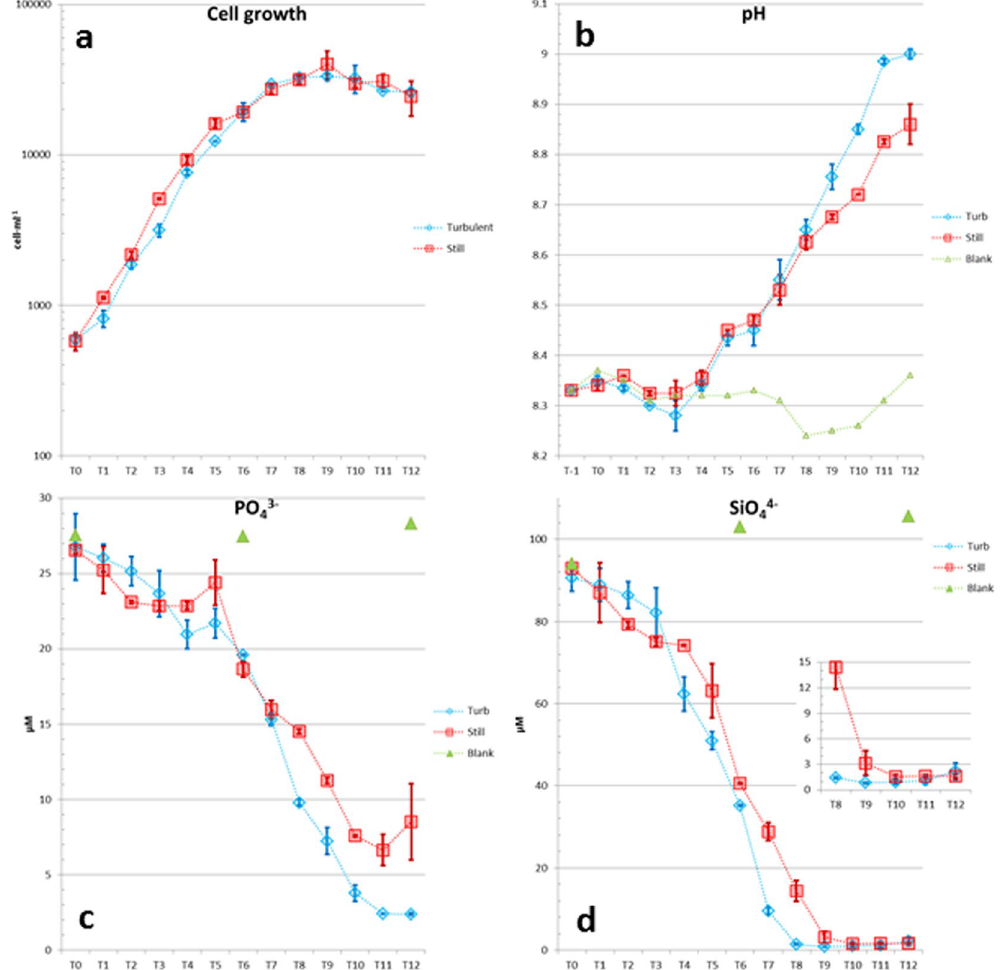
Figure 2. Growth curves ( a ), pH values ( b ) and nutrient concentrations ( c, d ) over the experimental days (T0- T12). ( a ). Cell concentrations over the experimental days. Logarithmic y axis. ( b ). Mean pH measurements. Still cylinders were always gently stirred before sampling (see methods). ( c ). Phosphate and ( d ). silicate measurements in Turbulent and Still conditions. Inset: zoom-in of the portion between T8 and T12. In the turbulent condition the threshold silicate concentration (ca. 1–2 µ M 33, 34 ) for diatoms was reached. Abscissa always represents experimental days. Values are means of the duplicates (n = 2) and vertical bars indicate maximum and minimum values. Blue diamonds indicate turbulent condition, red squares the still condition and, where applicable, triangles indicate measurements in the blank (supernumerary beaker where no cells were inoculated, see Methods).